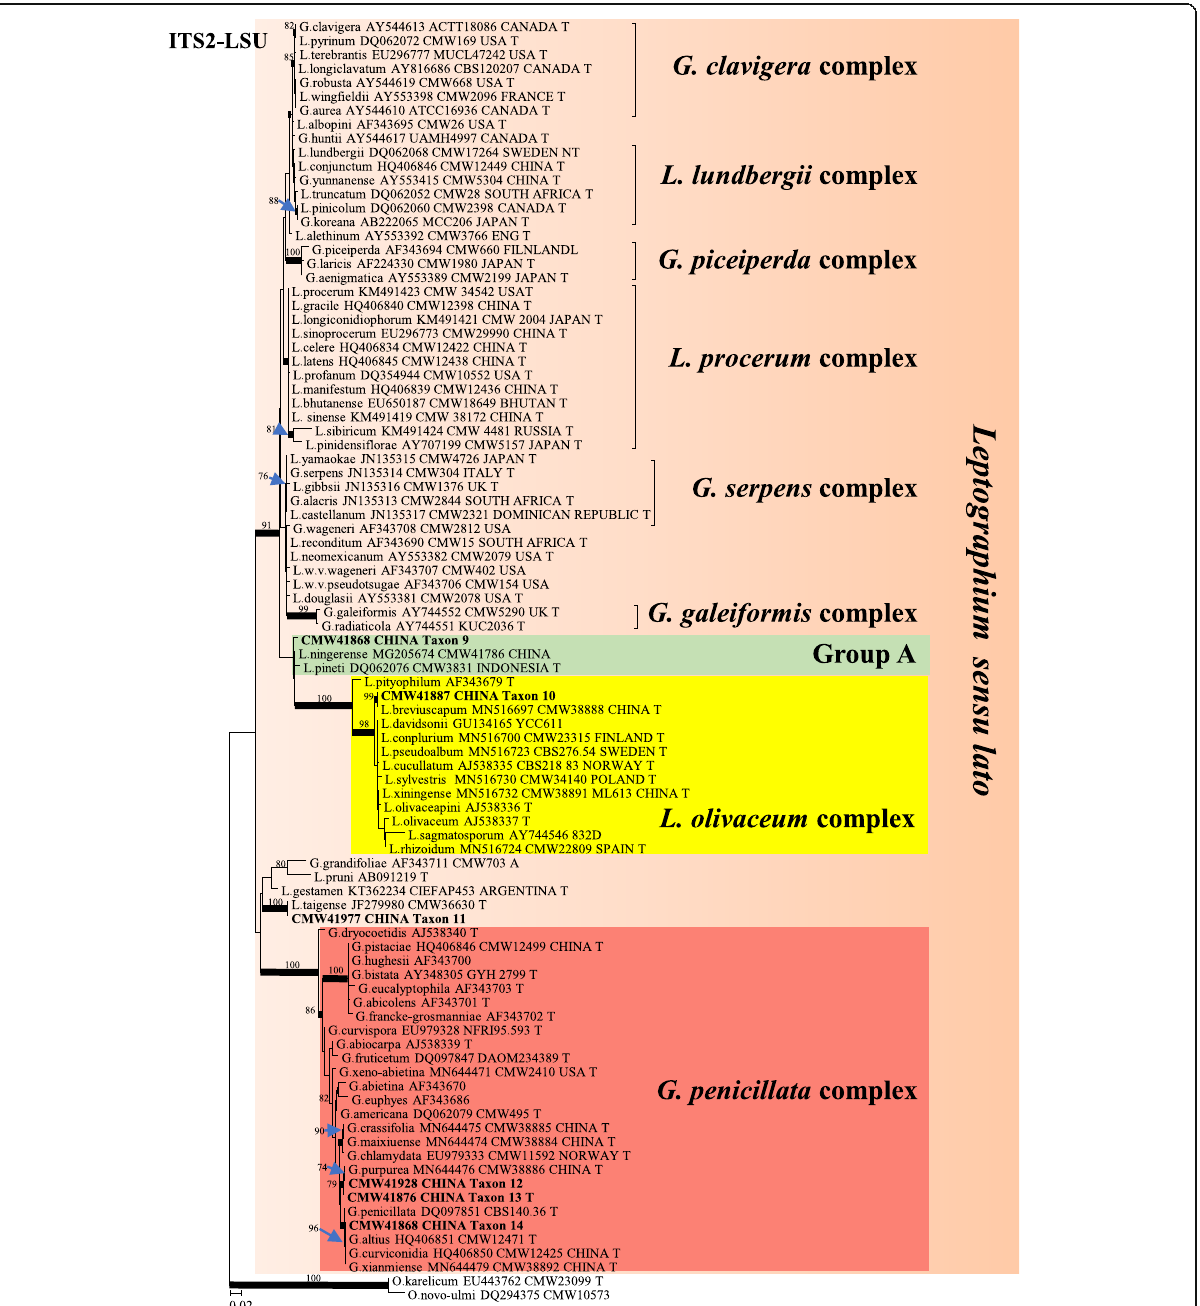
Fig. 2 Phylogram obtained from ML analyses of the ITS2-LSU region of Leptographium . Sequences obtained in this study are printed in bold type. ML bootstrap support values (1000 replicates, normal type) above 75% are indicated at the nodes. Posterior probabilities (above 0.9) obtained from BI are indicated by bold lines at the relevant branching points. T = ex-type cultures. Scale bar = total nucleotide difference between